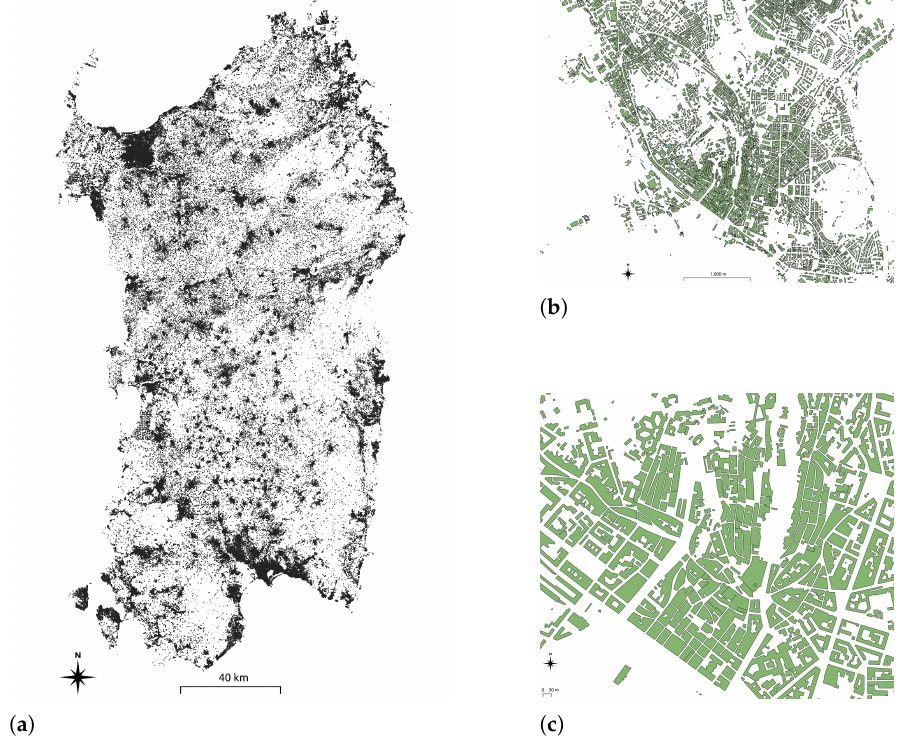
Figure 1. ( a ) Distribution of buildings (in black) in Sardinia and ( b , c ) building blueprints in the Municipality of Cagliari, the administrative center and largest city in